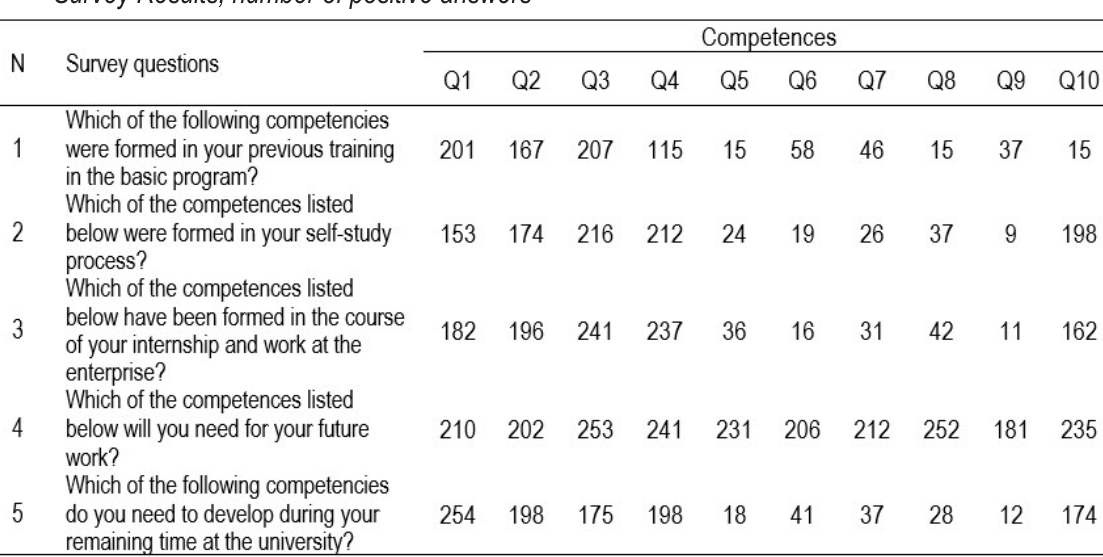
Survey Results, number of positive